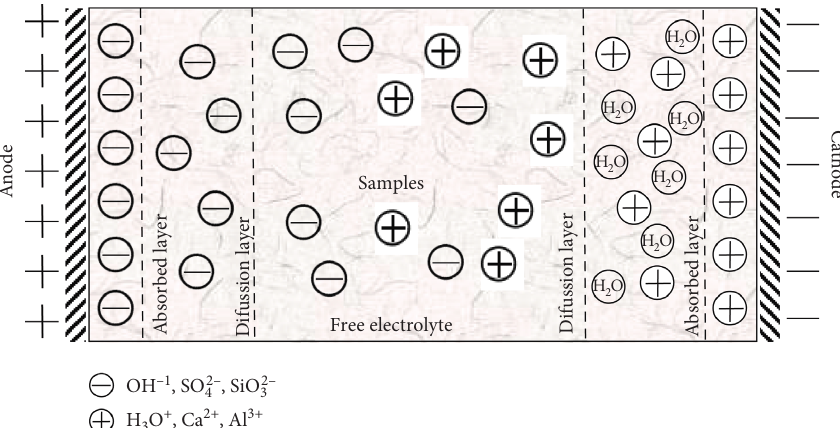
Figure 15: A schematic diagram of the migration of internal ions and free water in the HWBM under the electric field.